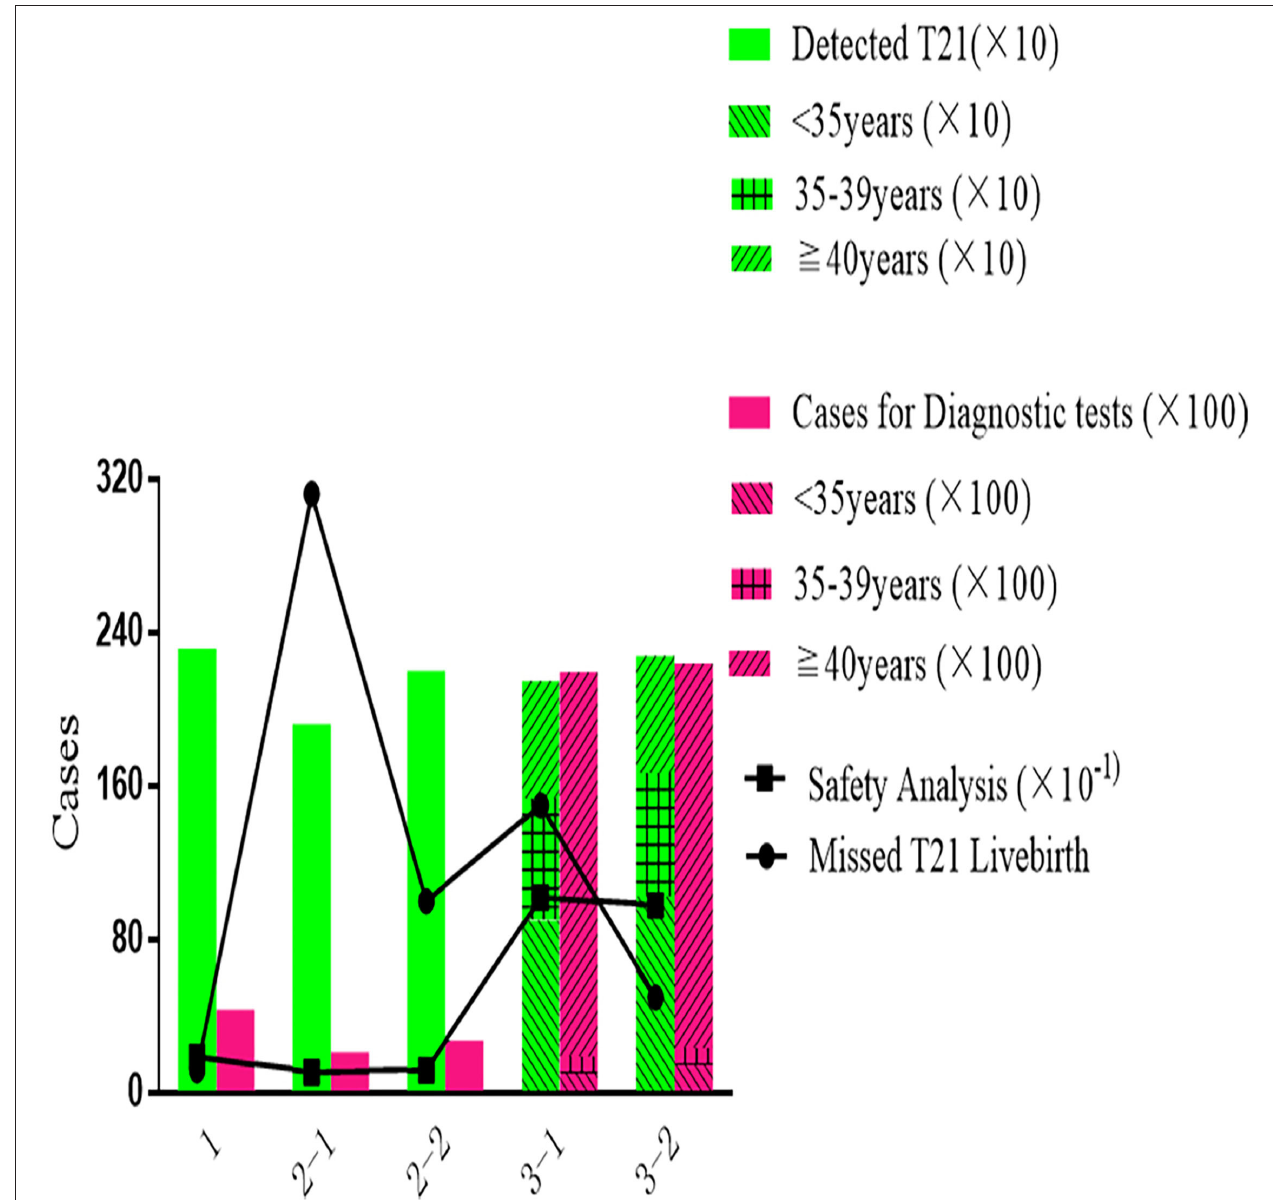
FIGURE 3 | The performance and accuracy of different